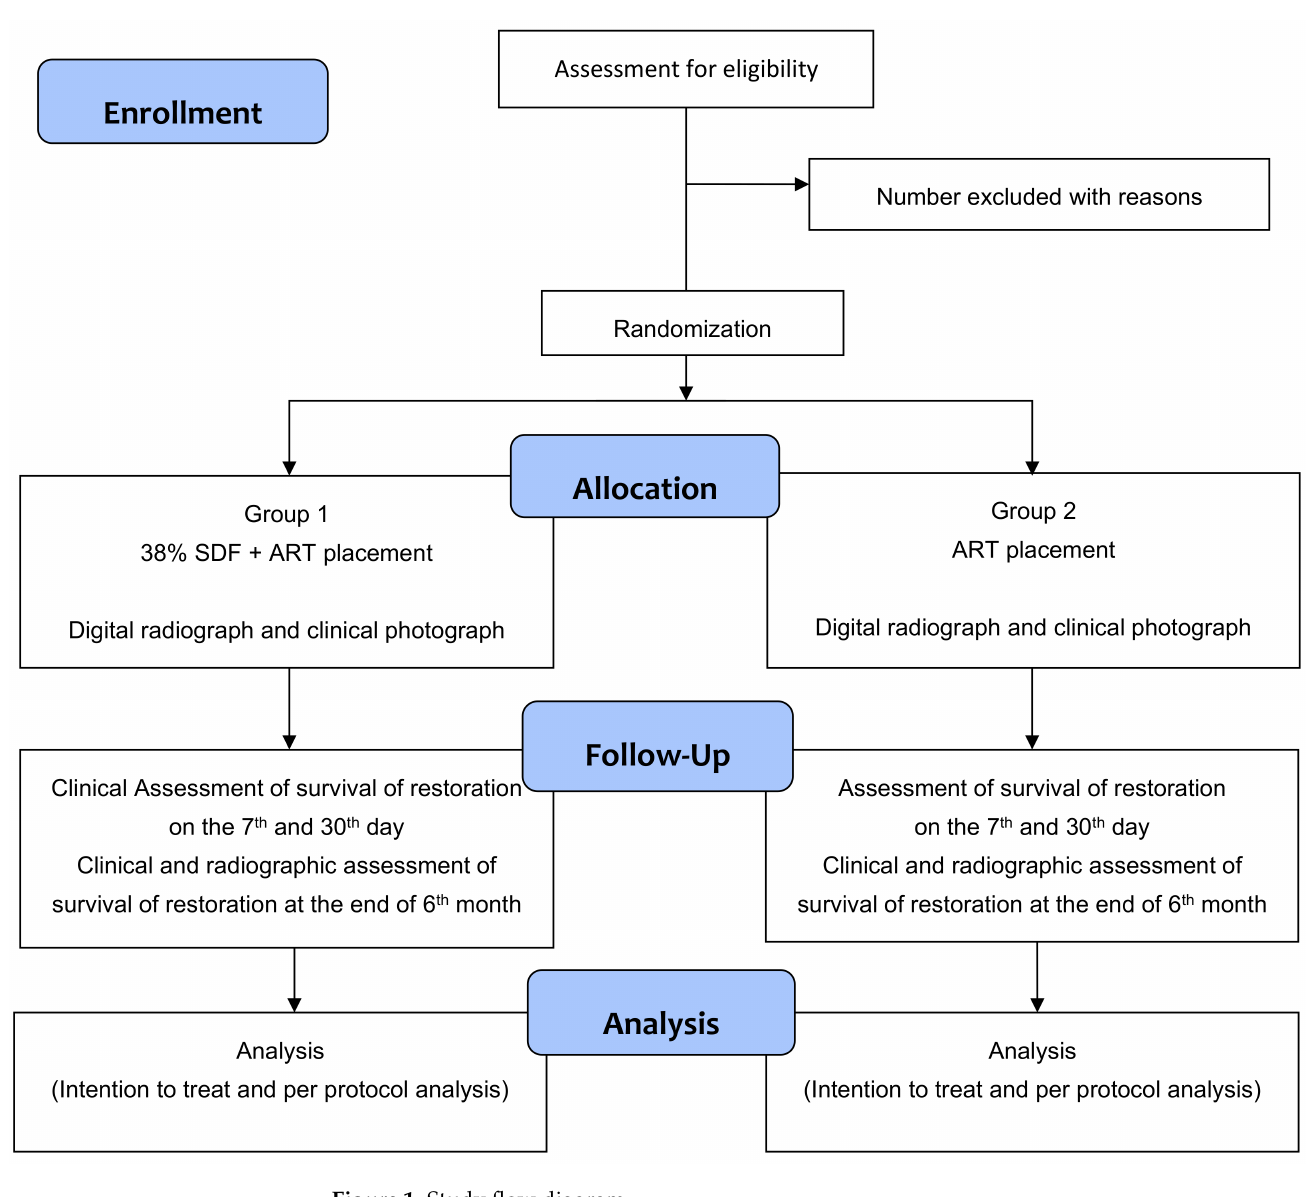
Figure 1. Study flow